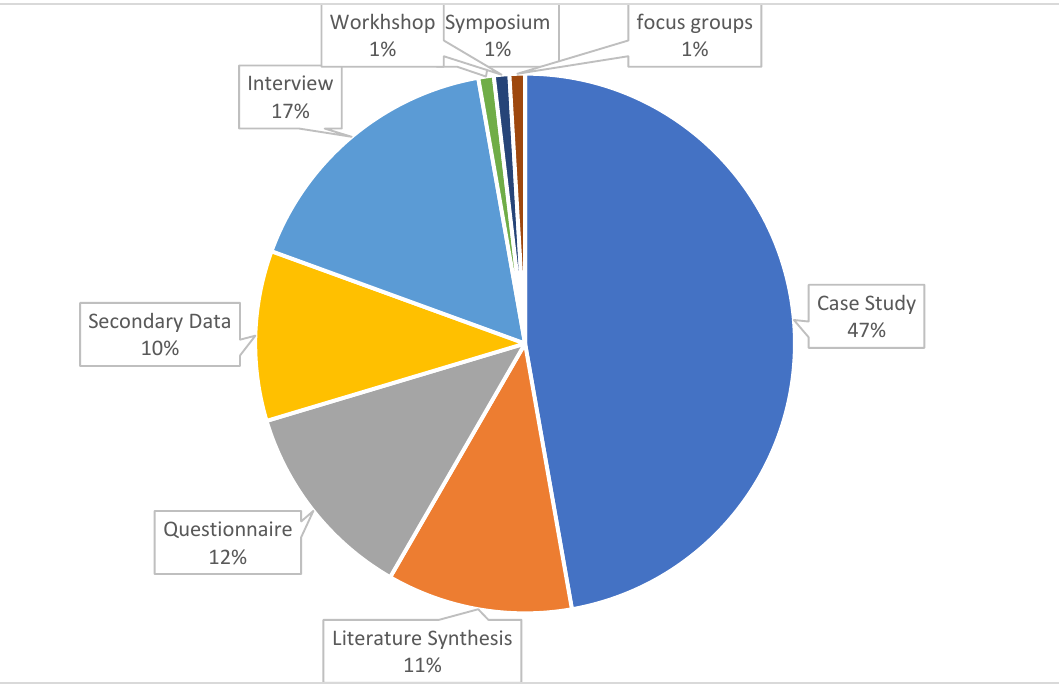
Figure 6. Data collection method of the documents considered in the current study.